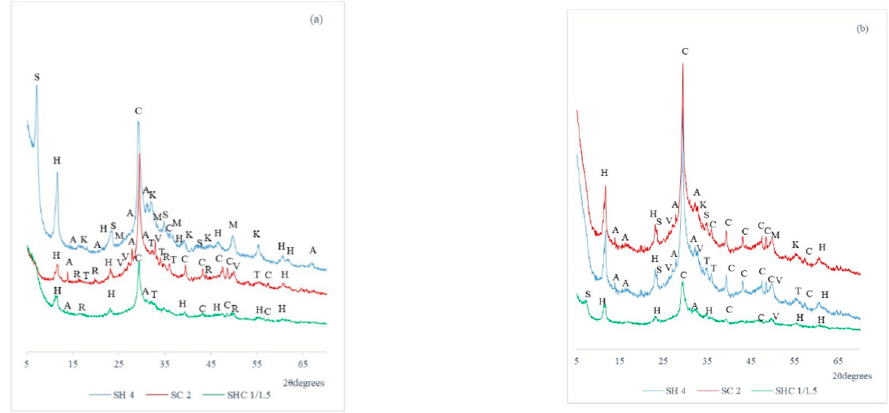
Figure 9. XRD spectra of the pastes cured for ( a ) 28 days and ( b ) 90 days. Table 5. Assignment of the XRD peaks in pastes.